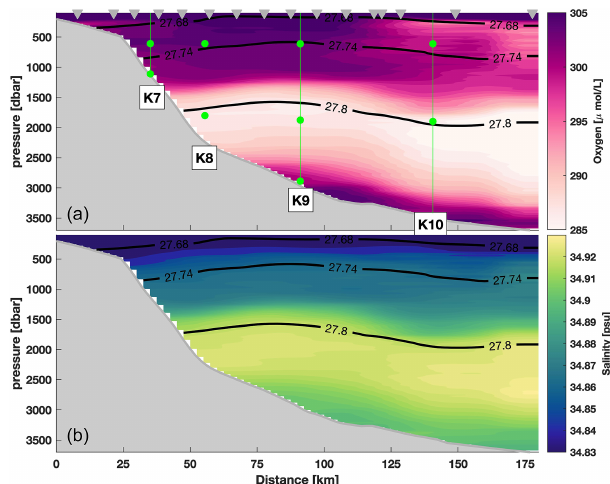
Figure 2. Oxygen and salinity sections along the array from ship- board measurements collected during four mooring deployment and recovery cruises (see Sect. 2.2). Gray symbols show stations from one representative cruise. Green symbols in (a) show deployment locations of the oxygen sensors, which were co-located with T – S sensors. Only data from the instruments at 600m depth are used in this study. The full coverage of current meters and T – S sensors is described in Zantopp et al. (2017). Black contours show the po- tential density range of 27.68kgm − 3 ≤ σ θ ≤ 27.8kgm − 3 for LSW and the σ θ = 27 . 74kgm − 3 isopycnal which delineates the upper Labrador Sea Water (uLSW) above and classical Labrador Sea Wa- ter (cLSW)